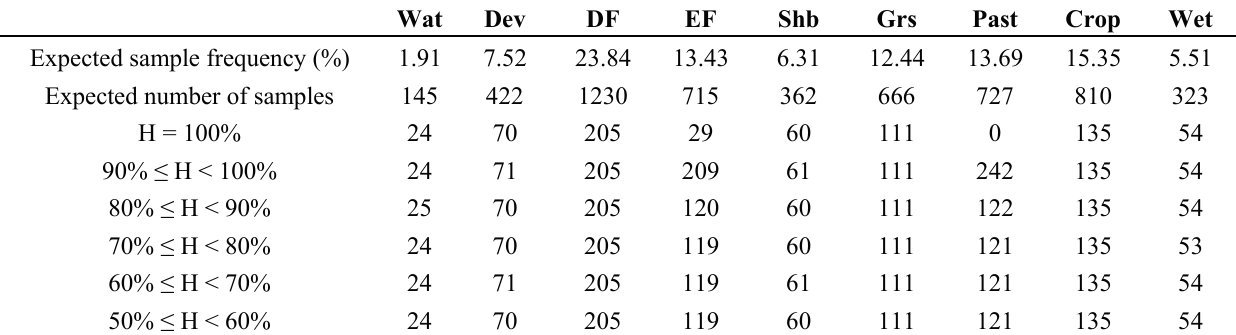
Table 5. Allocation proportional to expected area with a minimum of 50 samples per class using heterogeneous pixels with uniform allocation across six bins of H ≥ 50%. Homogeneity (H) in percent. For abbreviations of class names see Table 1.